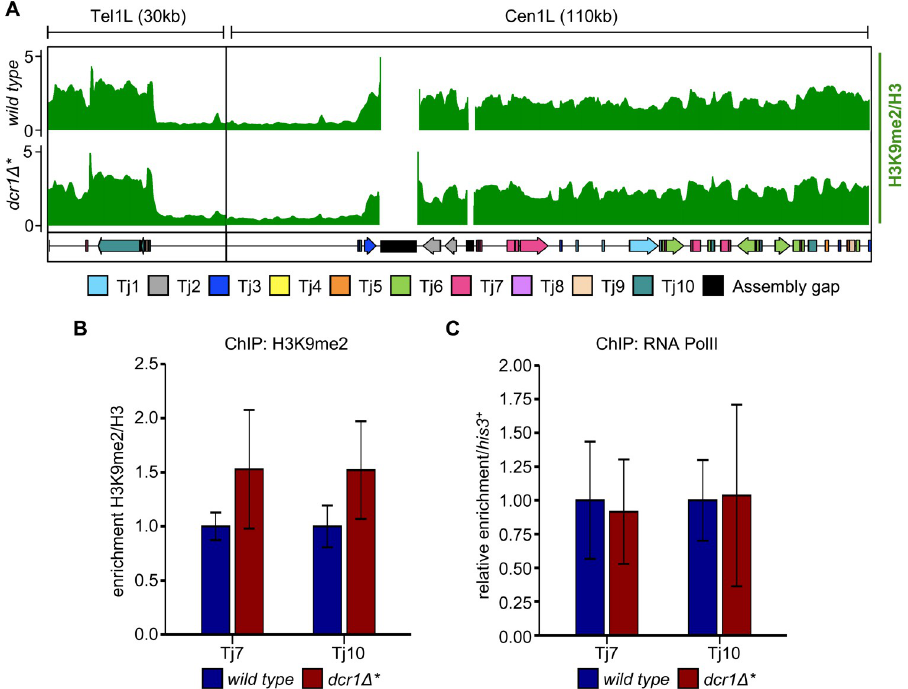
Fig 3. Levels of H3K9 methylation and transcription at retrotransposon loci are unaffected in rare dcr1 Δ survivors. (A) ChIP-seq profile of H3K9me2 across two retrotransposon-rich loci in wild-type and dcr1 Δ � cells. Enrichments are given in reads per kilobase million (RPKM) and represent the ratio of input normalised anti- H3K9me2 precipitated chromatin over input normalised anti-H3 precipitated chromatin. The positions of individual transposable elements are indicated by coloured arrows below the data track. (B) ChIP-qPCR analysis of H3K9me2/ H3 levels at Tj7 and Tj10 retroelements, relative to his3 + , normalised to wild-type. Data plotted are the mean ± SD from three replicates. (C) ChIP-qPCR analysis of RNA PolII levels at Tj7 and Tj10 retroelements, relative to his3 + , normalised to wild-type. Data plotted are the mean ± SD from three replicates.